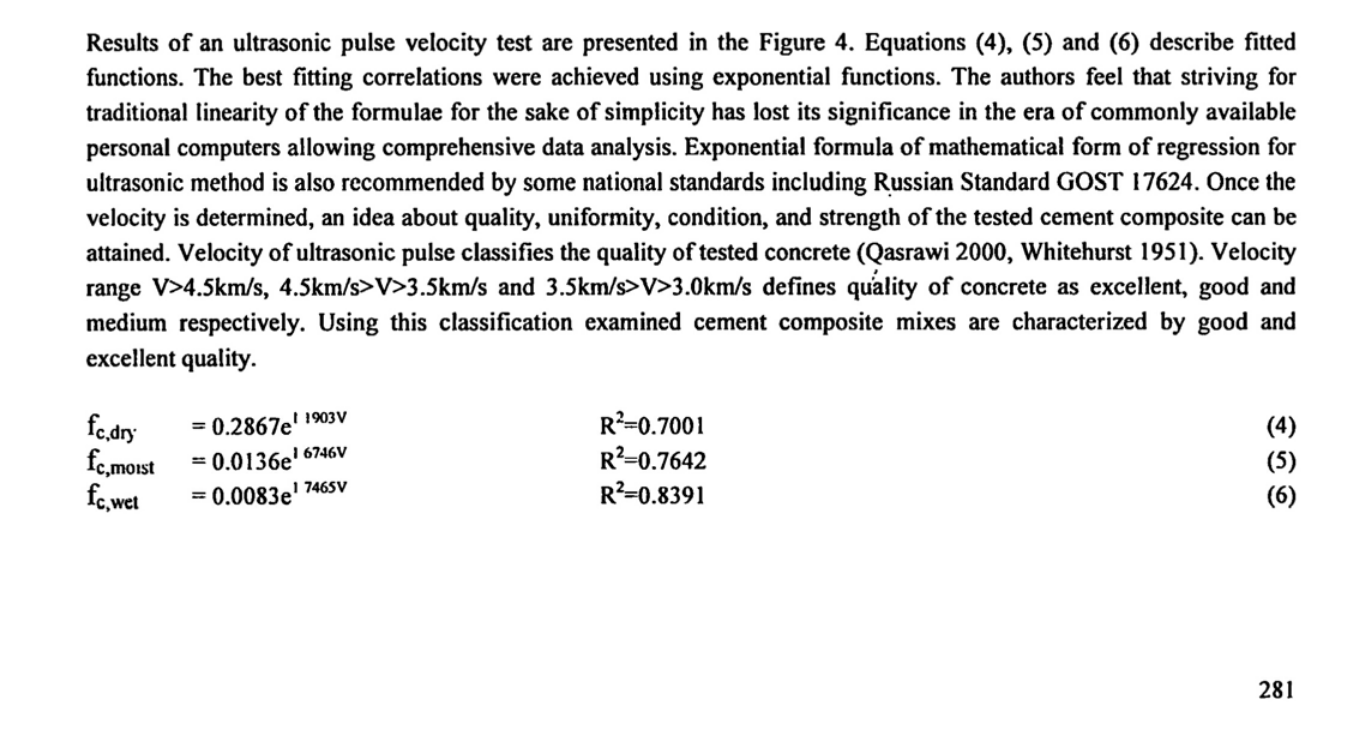
Fig. 3: Compressive strength of cement composites depending on